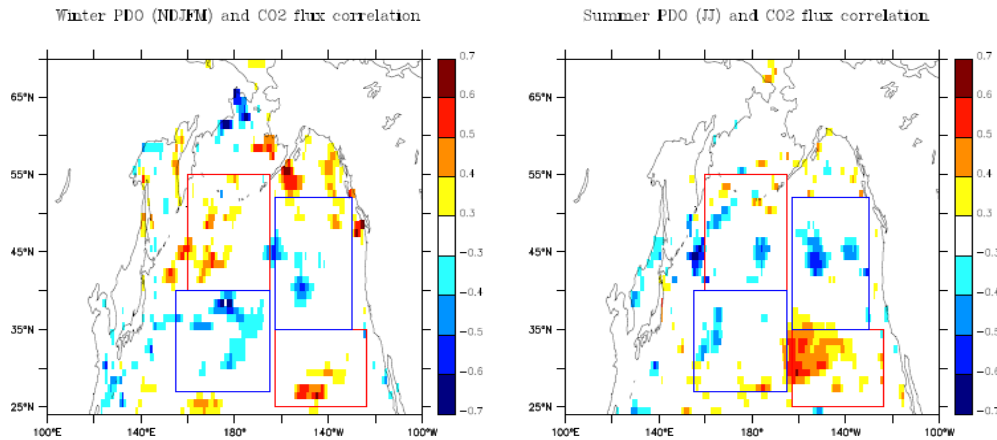
5 6 7 Fig. 7. Same as Fig. 4 left column but correlations are computed for (left) winter month and (right) summer month net air-to-sea CO 2 flux